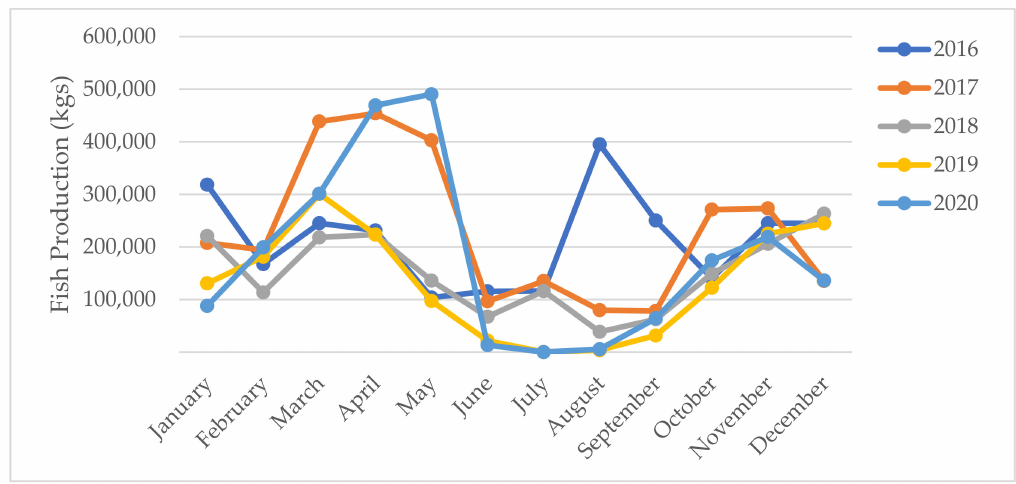
Figure 2. Fish Production per month 2016–2020 (Dadap Fish Auction Place, 2021)